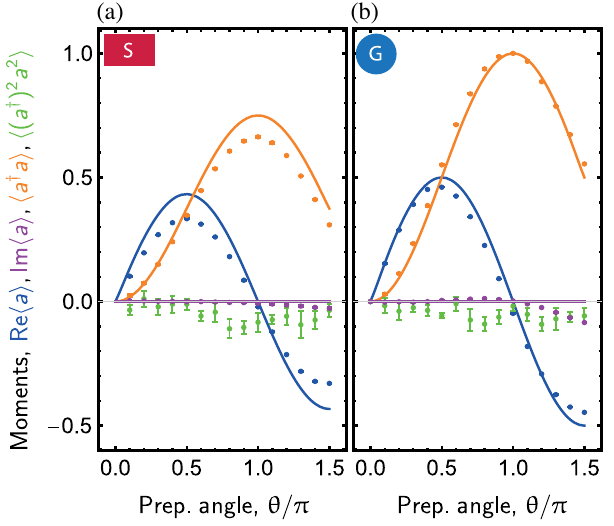
FIG. 11. Measured moments Re h a i (blue), Im h a i (purple), h a † a i (orange), and hð a † Þ 2 a 2 i (green), for superpositions j ψ i ¼ sin ð θ = 2 Þj 0 i þ cos ð θ = 2 Þj 1 i of vacuum and single-photon states emitted from (a) the source qubit and (b) the gate qubit. Lines indicate ideal expectation values, calculated taking into account photon loss between the source and the gate